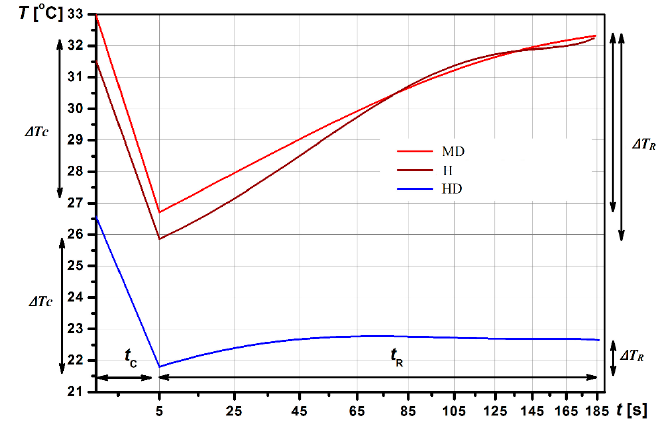
Figure 4. Dynamic thermal imaging outcomes registered for a randomly selected subject from the experimental group: High disease activity (HD), moderate disease activity (MD), healthy (H), t c = cooling, t R = rewarming, ∆ T R = total change in mean temperature due to rewarming, ∆ T C = total change in mean temperature due to cold